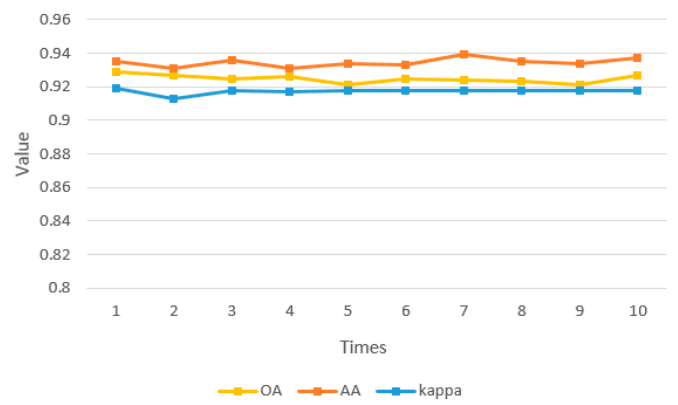
Figure 31. Results of 10 independent Monte Carlo trials.